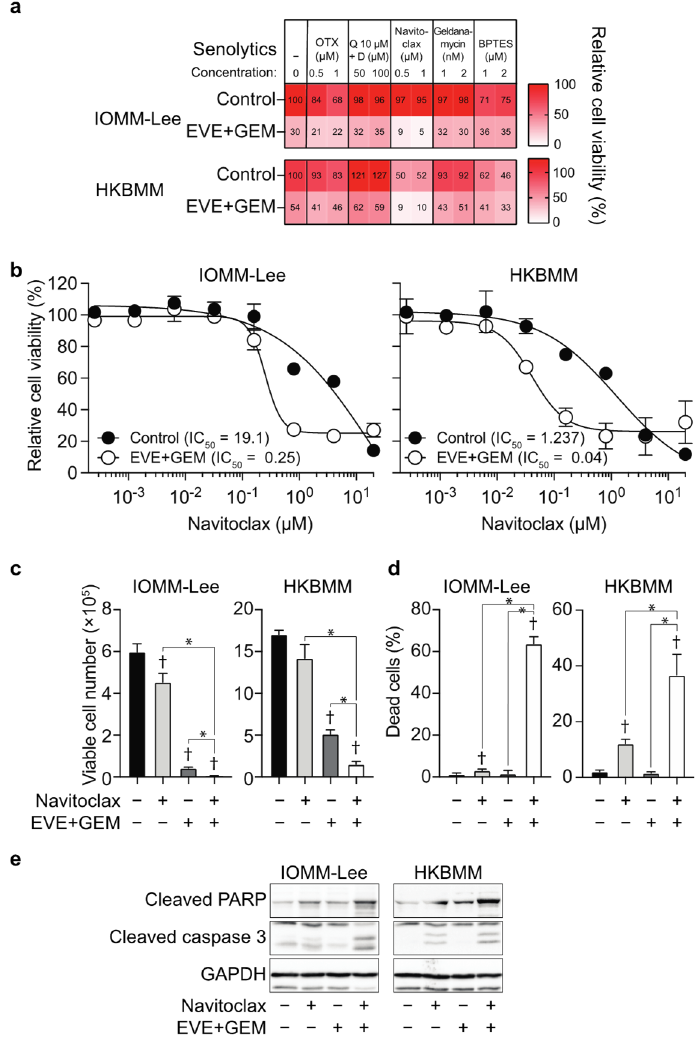
Figure 4. Enhancement of effects of everolimus and gemcitabine by navitoclax. IOMM-Lee